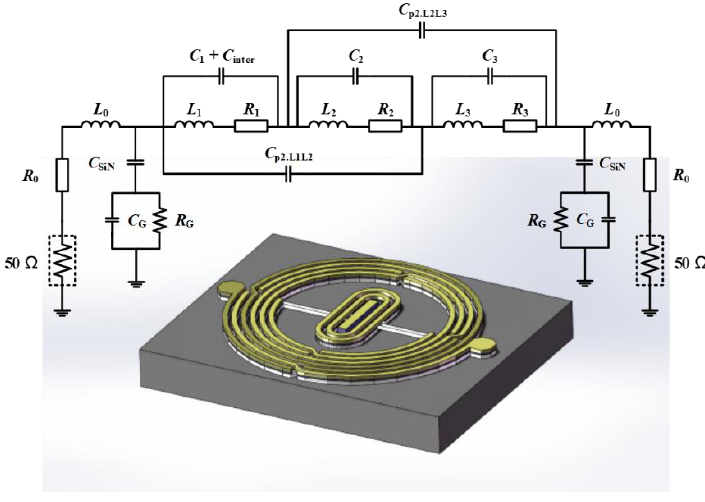
Figure 3. Equivalent circuit of the proposed BPF.